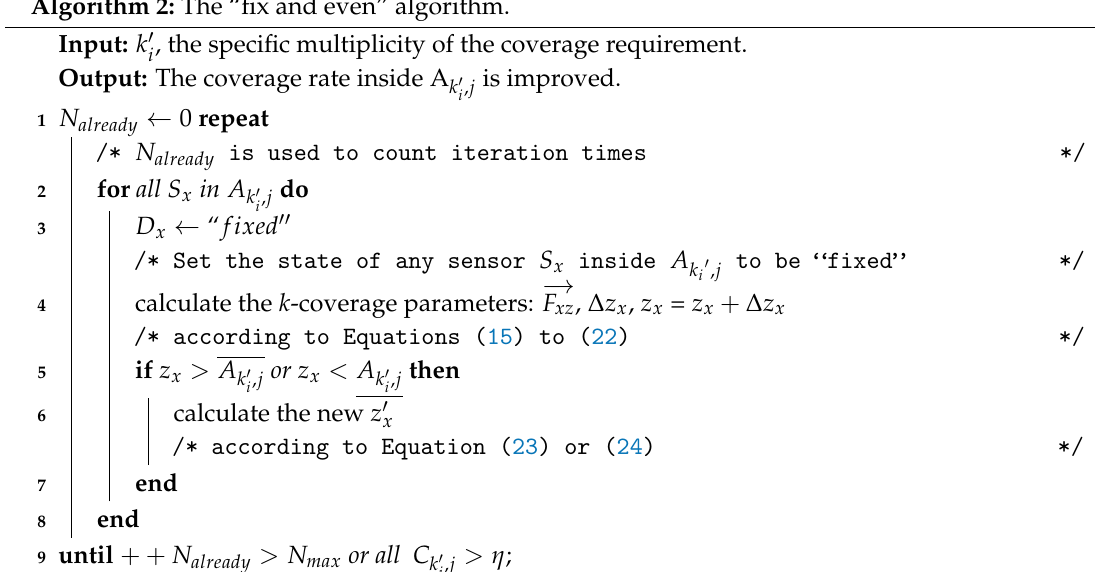
Algorithm 2: The “fix and even”